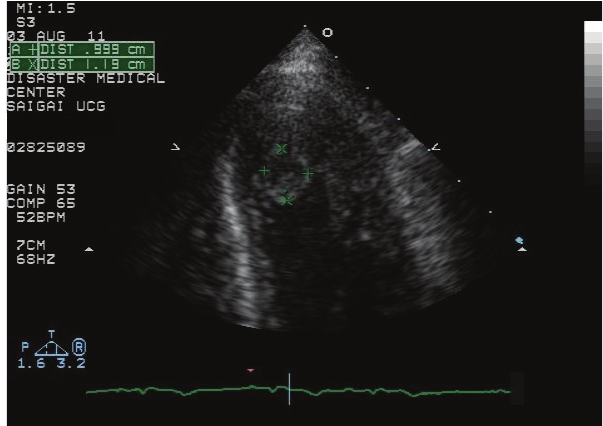
Figure 2: Echocardiogram showed a mobile mural thrombus in the apex of left